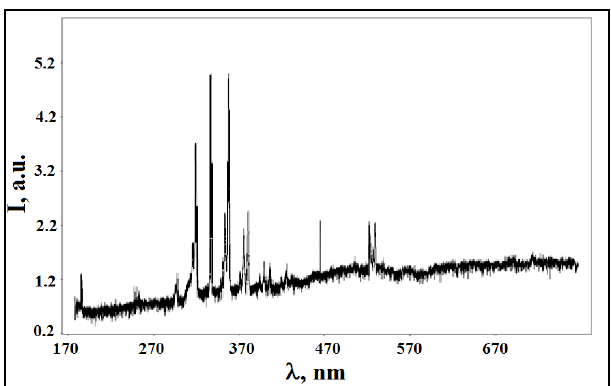
Figure 6. The emission spectrum of the discharge above the surface of a 5% solution of CuSO salt in distilled water at 4 an air pressure in the discharge chamber equal to 6.5 kPa.